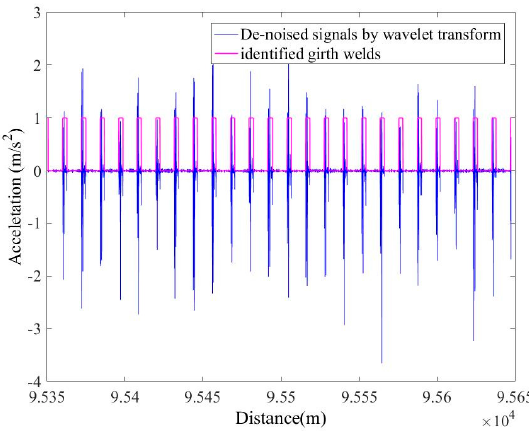
Figure 10. Identification of pipeline girth weld.